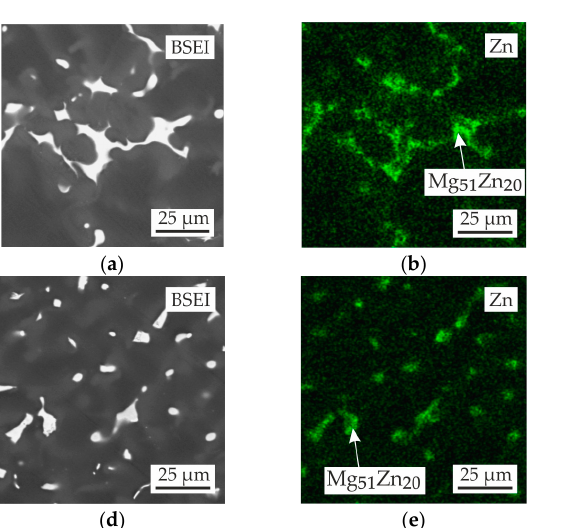
Figure 3. Microstructure of the ( a – d ) MgZn4Ga4, ( e – h ) MgZn4Ga4Y0.5, ( i – l ) MgZn6.5Ga2, ( m – p ) MgZn4Ga2, and ( q – t ) MgZn2Ga2 alloys in the ( a , e , i , m , q ) as-cast condition, ( b , f , j , n , r ) after HT for 15 h at 300 °C + 30 h at 400 °C, and after hot extrusion at ( c , g , k , o , s ) 150 or ( d , h , l , p , t ) 200 °C. The insets with pink boxes show higher-magnification images, while those in blue boxes show the microstructure after etching (only for extruded alloys).